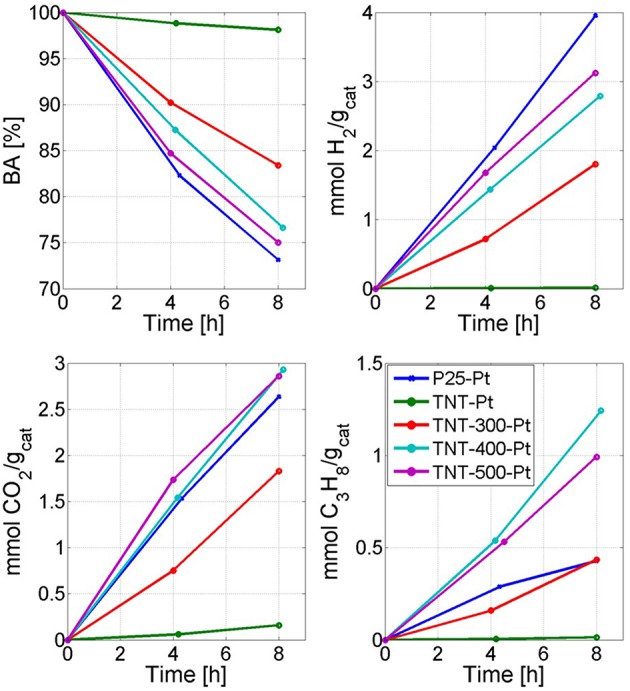
Reactivity results. Time refers to the irradiation time. The legend applies to all four plots.